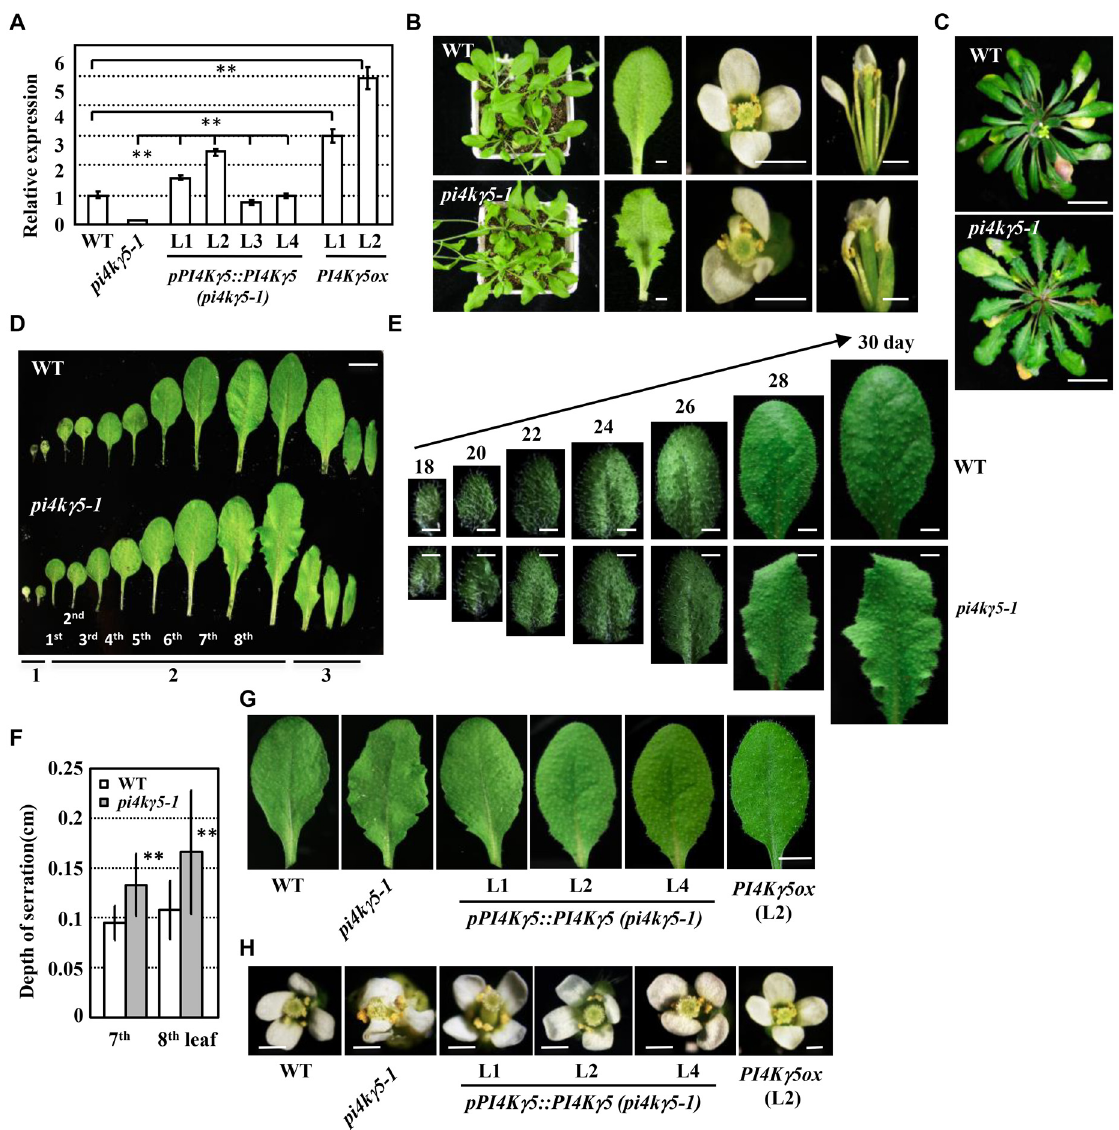
Fig 2. Identification and phenotypic analysis of knockout mutant pi4k γ 5 – 1 . A. qPCR analysis of the PI4K γ 5 transcription level in WT and homozygous pi4k γ 5 – 1 mutant, WT or pi4k γ 5 – 1 plants expressing PI4K γ 5 driven by its own native